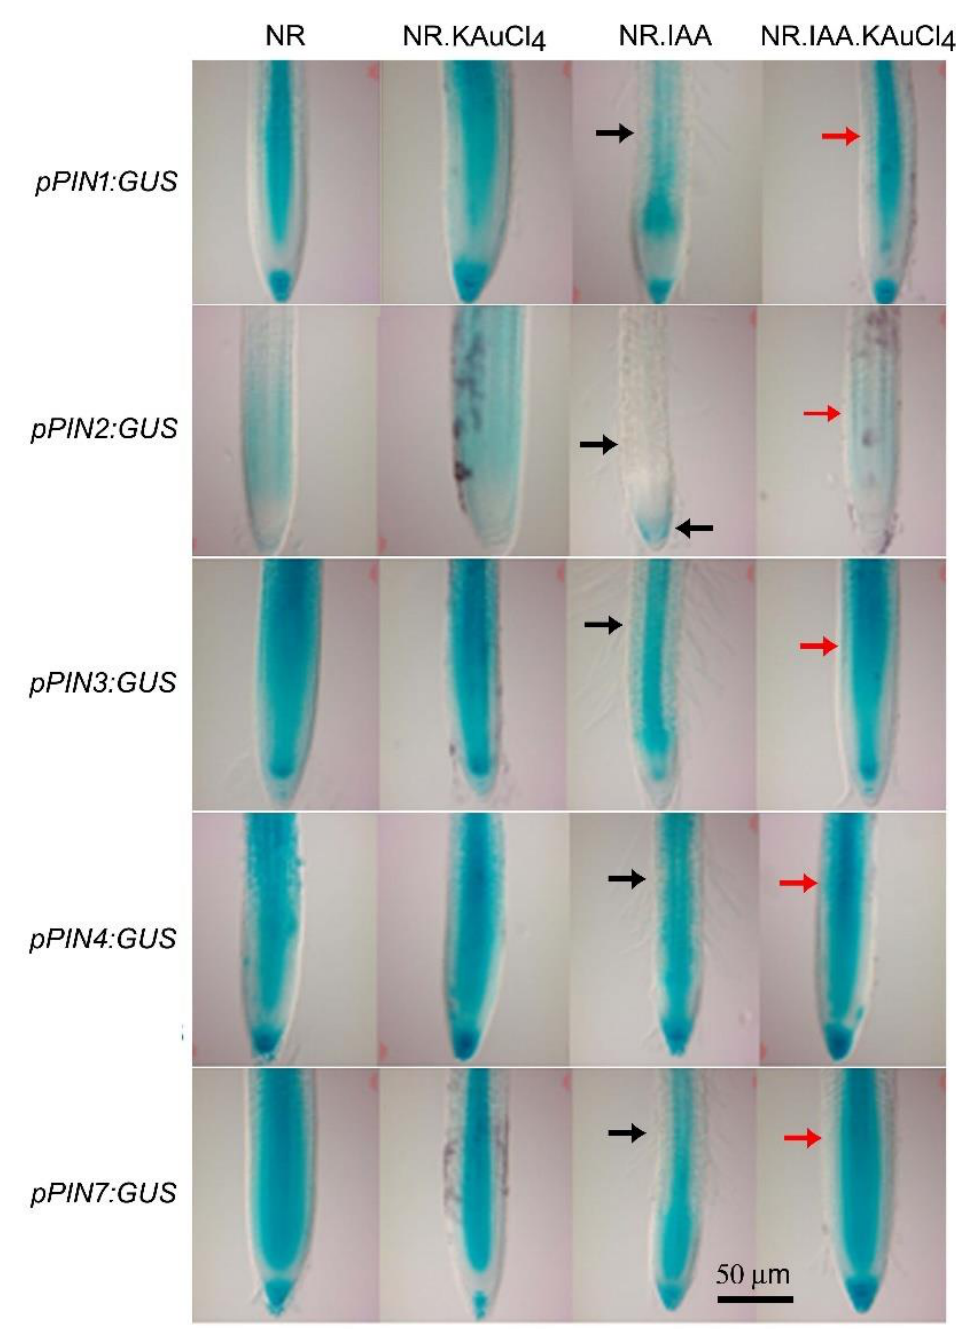
Figure 8. Differential recuperating effects of KAuCl 4 on IAA-mediated spatial expression patterning of the PIN genes in the primary root. The pPINs:GUS transgenic seedlings were grown hydroponically in the NR medium for 7 d and then transferred to NR, NR.KAuCl 4 , NR.IAA, and NR.IAA.KAuCl 4 media for a further 7 d, as described in the legend of Figure 5. Histochemical GUS-stained primary root tip showing the expression of pPIN1:GUS , pPIN2:GUS, pPIN3:GUS, pPIN4:GUS , and pPIN7:GUS. Black arrows indicate the NR.IAA-mediated reduced expression of the PIN genes, and red arrows show the effects of NR.IAA.KAuCl 4 treatment upon the restoration of the spatial expression pattern of these